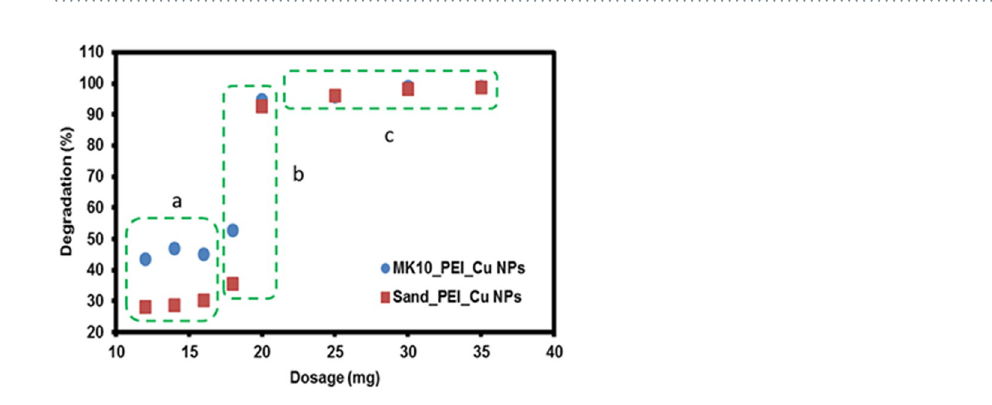
(marked as area “c” by a green dashed box in Fig. 5; points are over lapped) consequently, this (30 mg) “saturation dosage” was employed for further study. Effect of pH. The influence of pH on atrazine degradation with PEI_Cu NPs, modified MK10 and sand was also studied. The pH of the reaction mixture was adjusted with different acids (HCl, H 2 SO 4 and H 3 PO 4 ) and bases (NaOH and K 2 HPO 4 ). The pH remained constant throughout the experiments. In all cases, maximum ( > 99%) degradation of atrazine was observed (this is comparable to regular Fenton type reactions; therefore no plots are shown). Different patterns and levels of atrazine degradation were observed when the solution was treated with H 3 PO 4 and K 2 HPO 4 (Fig. 6). This distinct behavior of H 3 PO 4 and K 2 HPO 4 adjusted solution pH versus atrazine degradation is discussed hereafter. The PEI_Cu NP suspension, modified clay and sand show different percentages of atrazine degradation and various patterns (Fig. 6), when plotting atrazine degradation vs. solution pH (adjusted with H 3 PO 4 ). The mod- ified MK10 shows a sigmoidal type curve (Fig. 6) and a maximum degradation of 87.8%; modified sand and PEI_Cu NP suspensions show a different degradation pattern with lower degradation rates (44.9% and 63.7%, respectively). The lower atrazine degradation may be influenced by the ionic species of H 3 PO 4 and its affinity to copper. Furthermore, the steric interference of the aliphatic chains (from PEI) in PEI_Cu NPs cannot be ignored as a factor affecting the degradation. With this pH condition (stabilized by K 2 HPO 4 ), the reaction is faster for alkaline pH (8 > 7 ≫ 6 … ); this appears to be opposite to the “classical” Fenton reaction, where (strong) acidic conditions are needed. This